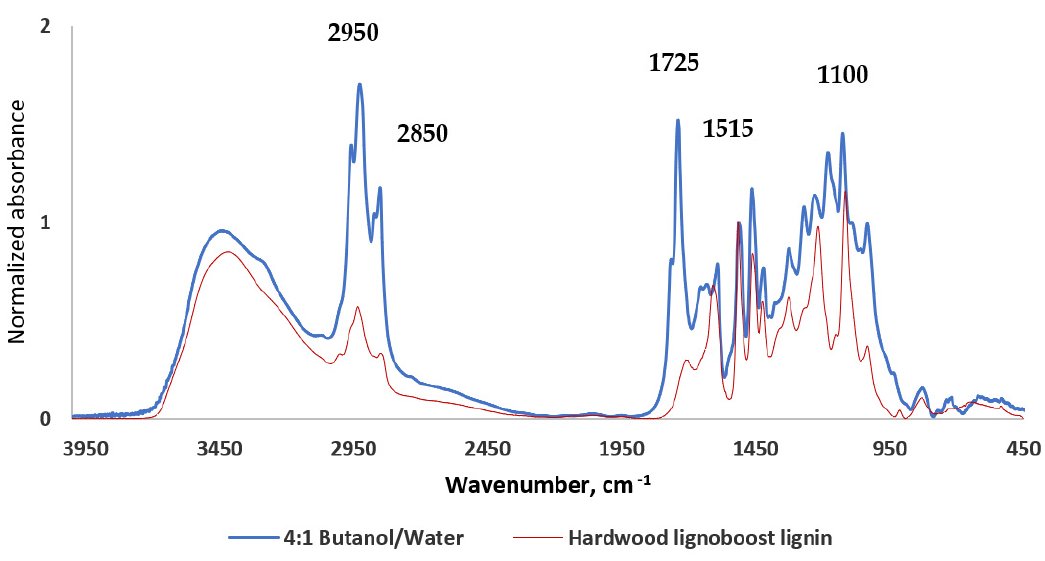
Figure 7. FTIR spectra of lignin-enriched fraction obtained with butanol/water solvent system compared to hardwood LignoBoost lignin, both normalized at 1515 cm − 1 .